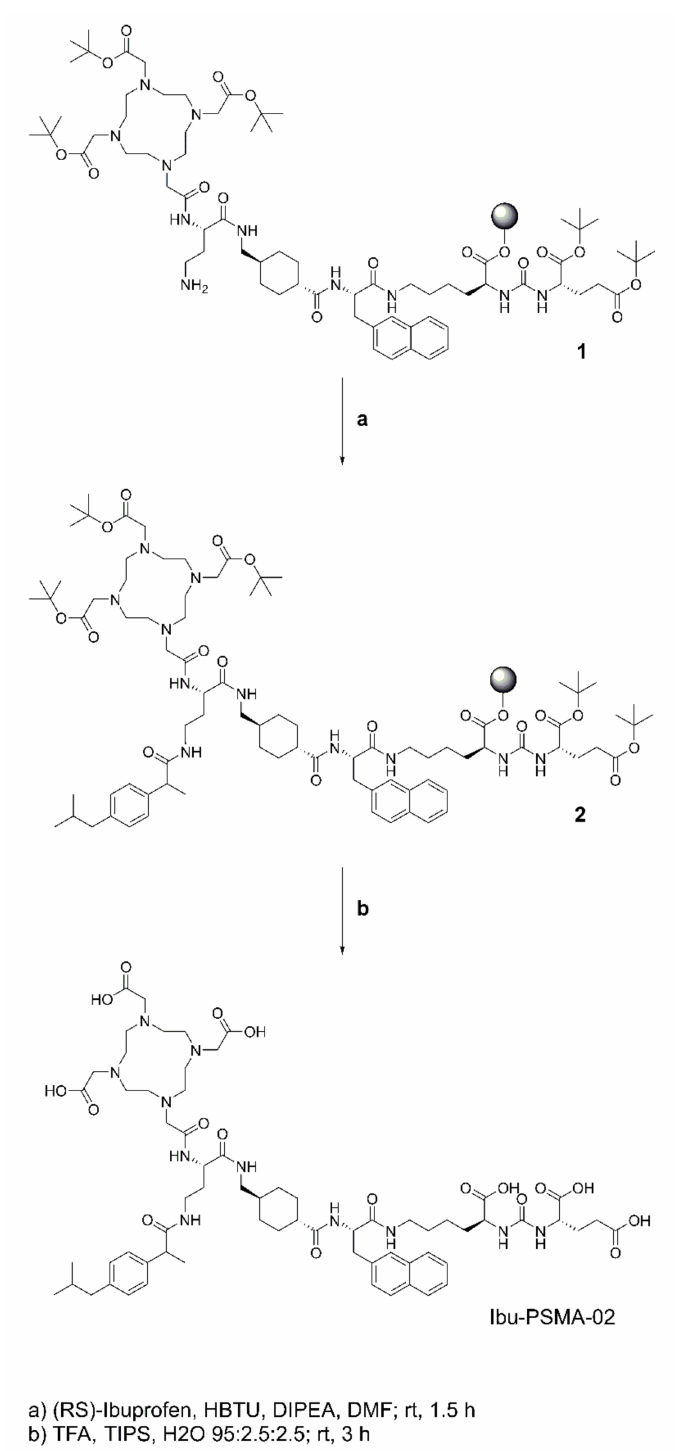
Scheme 1. Synthesis of Ibu-PSMA-02 based on precursor 1